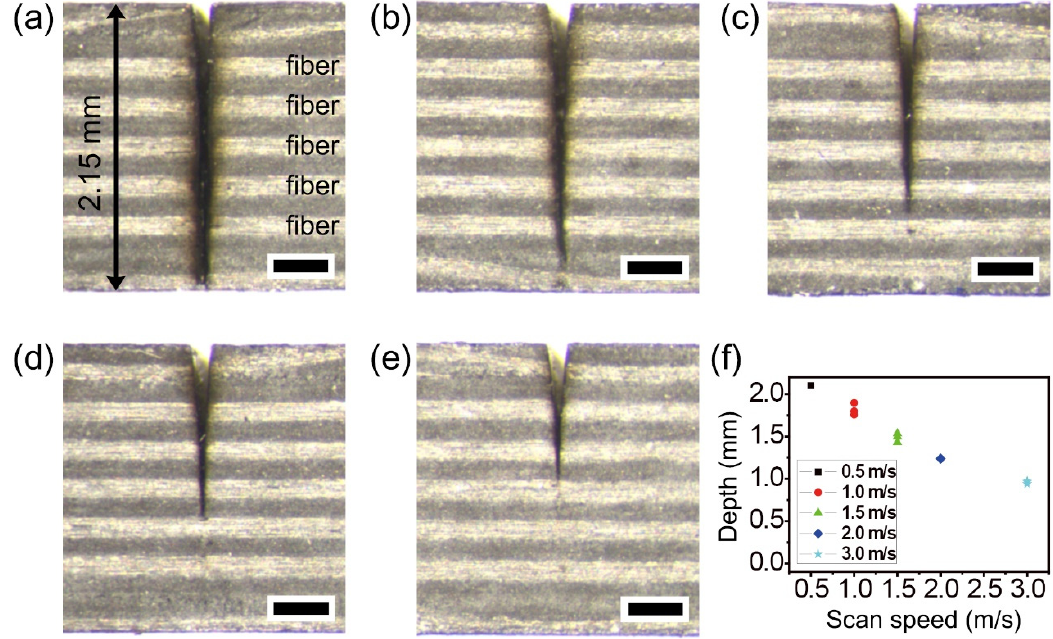
Figure 4. Picosecond laser cutting of the thermoset CFRP with scan speed variation. Stereoscopic microscope cross-section images with a scan speed of ( a ) 0.5, ( b ) 1.0, ( c ) 1.5, ( d ) 2.0, and ( e ) 3.0 m/s, respectively. Each scale bar = 400 µm. ( f ) Graph of cutting depths by scan speed variation. The common experimental conditions were a power of 22 W, 100 loops, and 10 passes with 10 µm gap.